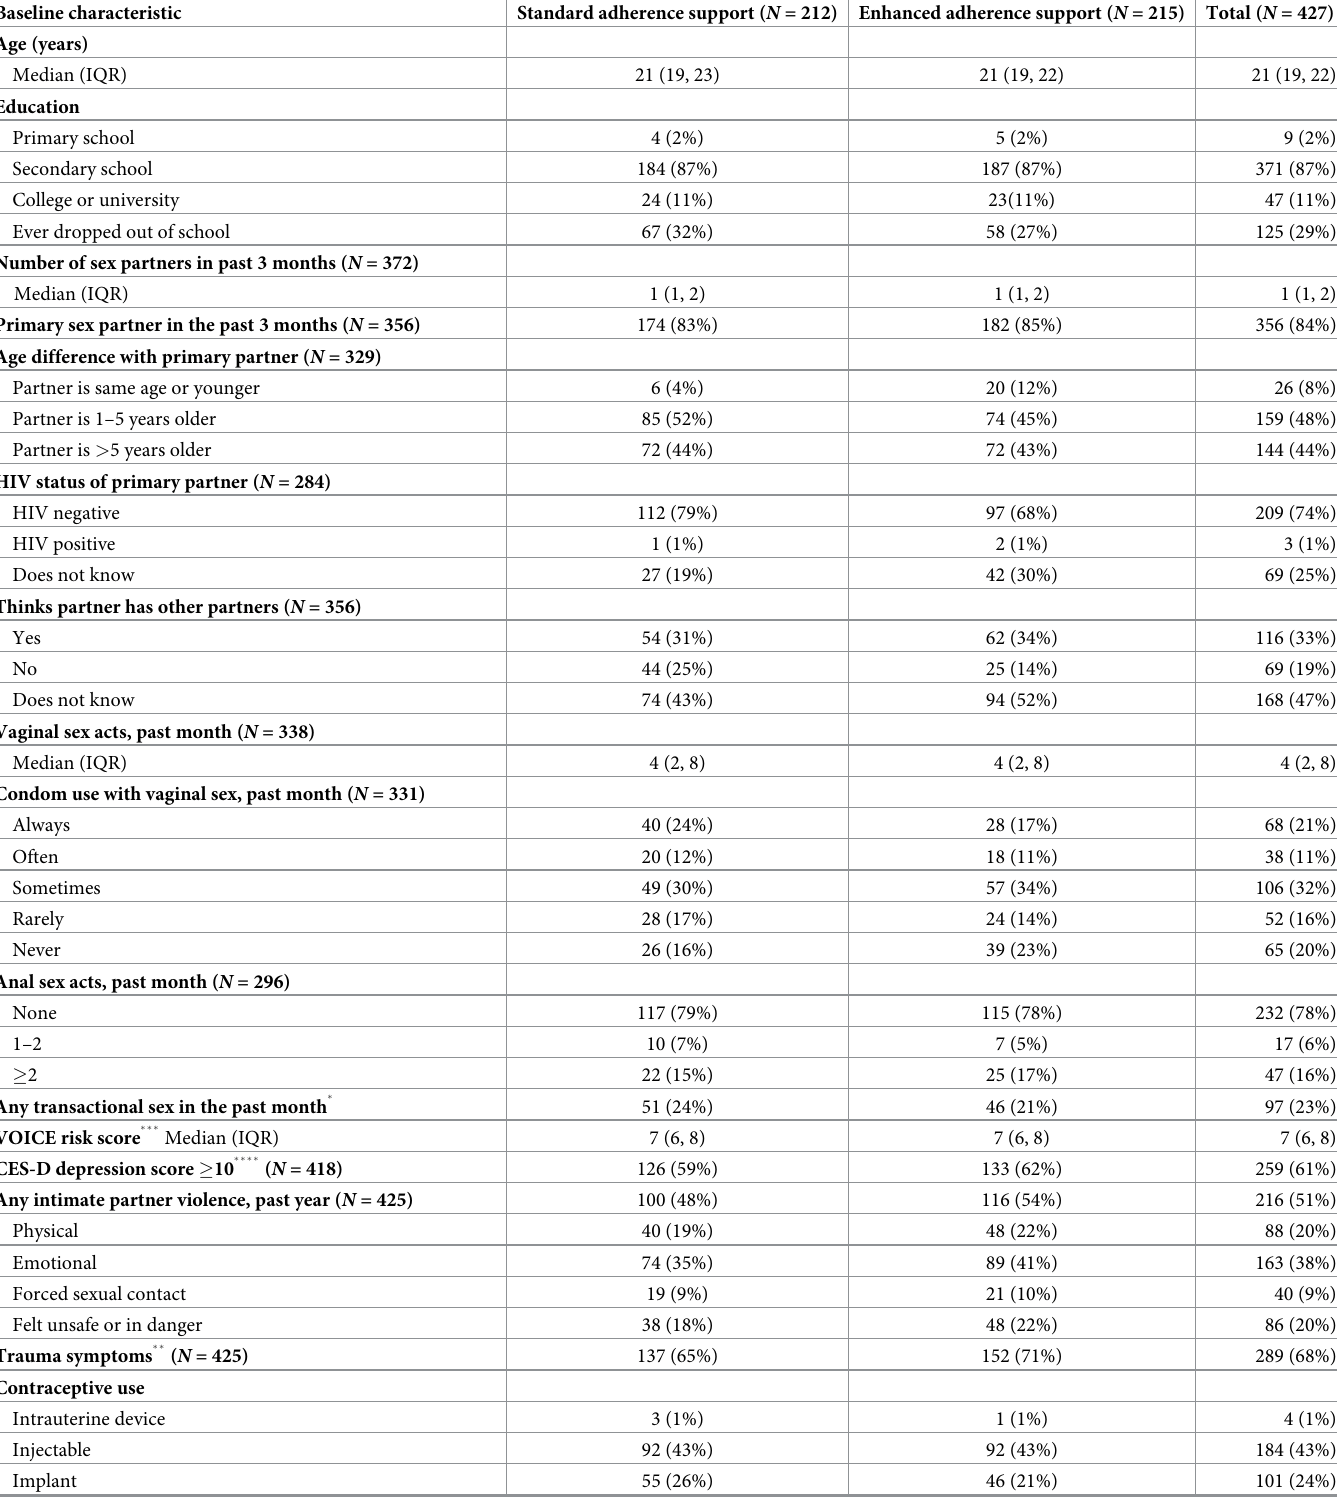
Table 1. Baseline demographic and behavioral characteristics of women who initiated PrEP in HPTN 082. Baseline